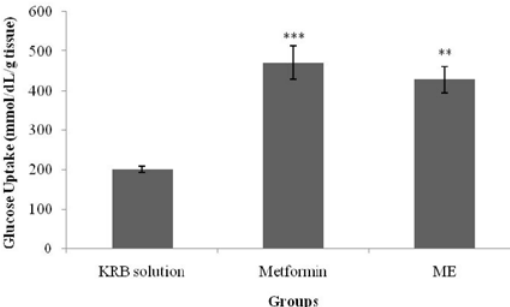
Figure 7. Effects of the methanolic extract (ME) of S. polyanthum and metformin on glucose uptake by isolated rat abdominal muscle in the presence of insulin. Values are expressed as mean ± standard error of the mean (SEM) ( n = 5); ** p < 0.01, *** p < 0.001 compared with the control group (KRB solution).